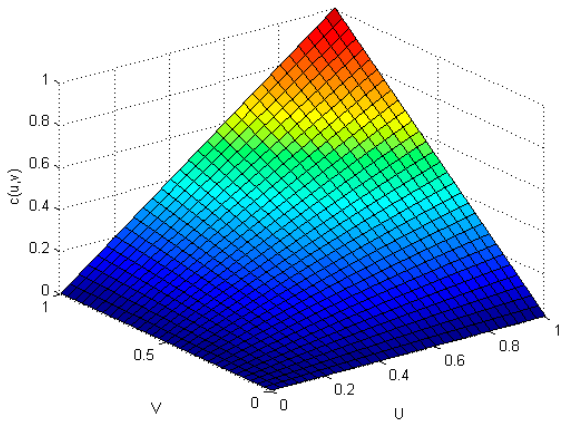
Figure 10. Distribution function diagram of U and V .